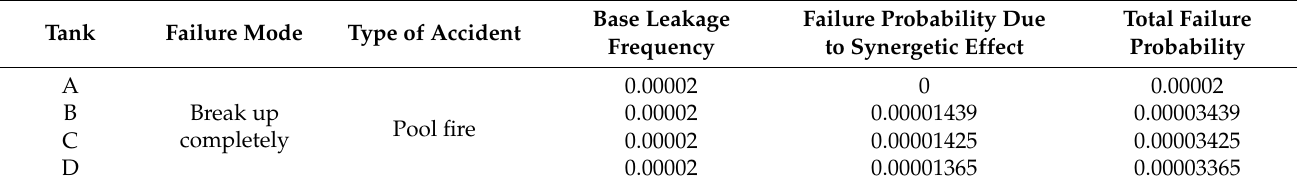
Table 4. Failure probability of storage tank.